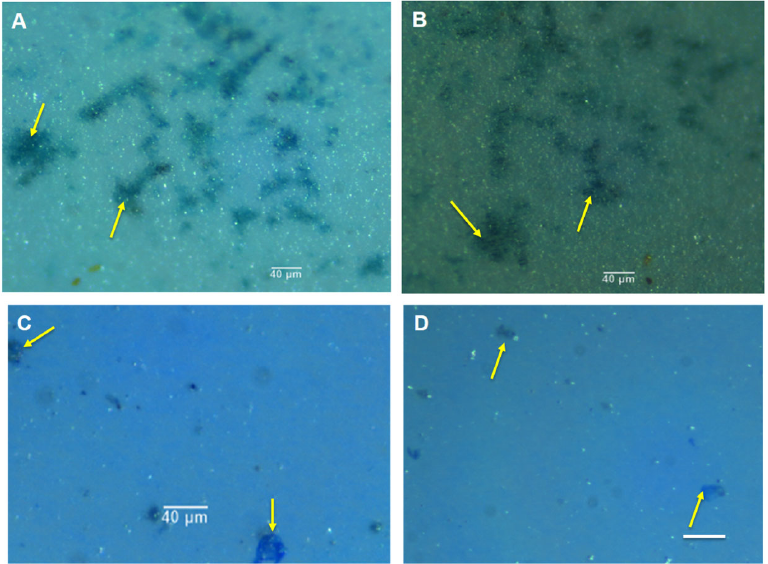
Figure 2. MGP from off the Northumberland coast (North Sea), visualised using bright-field mi- croscopy with fibre light. The MGPs were stained with Alcian blue dye (( A , B ); yellow arrows) and with Coomassie blue (( C , D ); yellow arrows). Scale bar = 40 µ m. Images captured using upright Leica microscope and fibre light with 10 ×